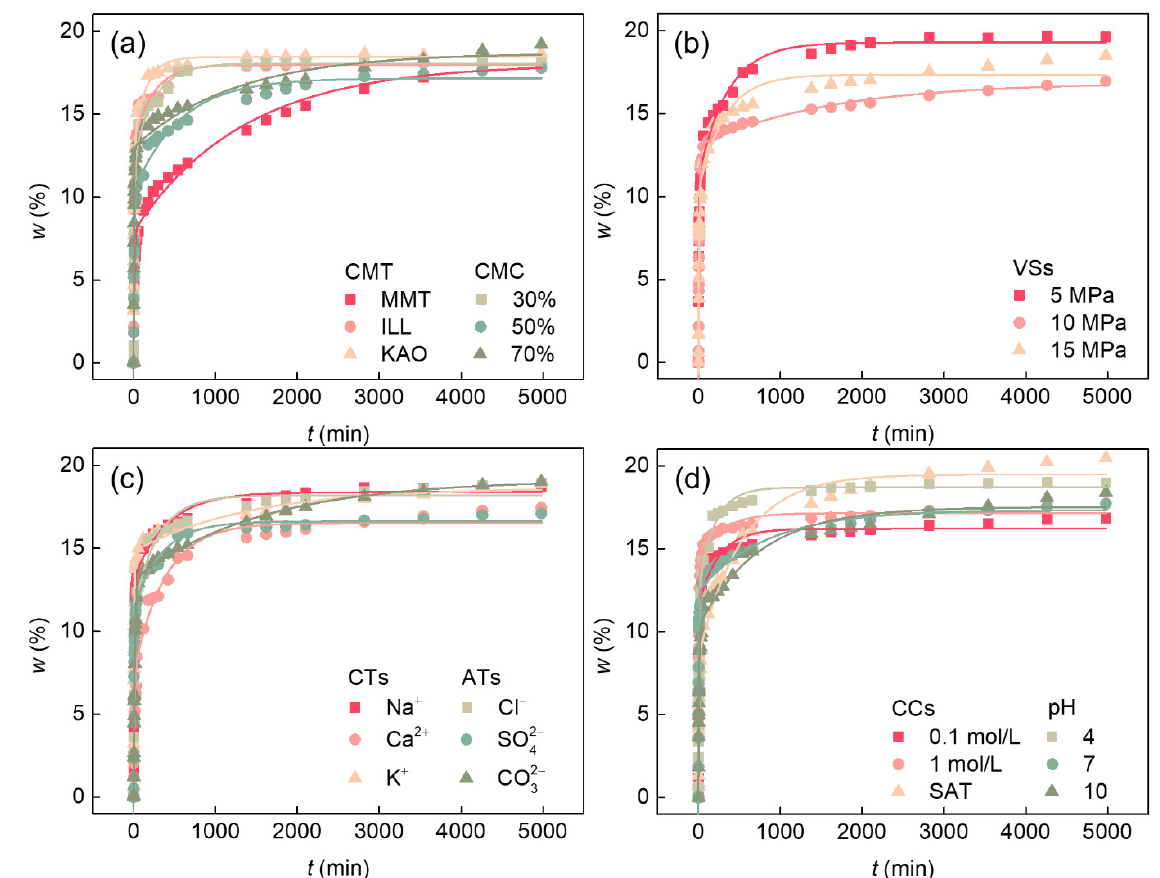
Figure 6. Water content w with time t as affected by: ( a ) clay mineral type (CMT) and clay mineral content (CMT), ( b ) vertical stress (VSs), ( c ) cation type (CTs) and anion type (ATs) and ( d ) concentration (CCs) and pH value (pH).